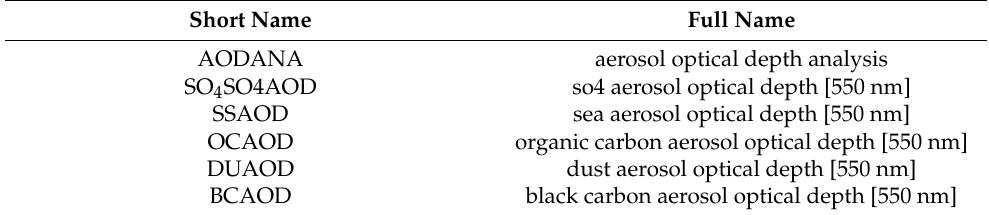
Table 1. Basic information about the aerosol optical depth that was used in this